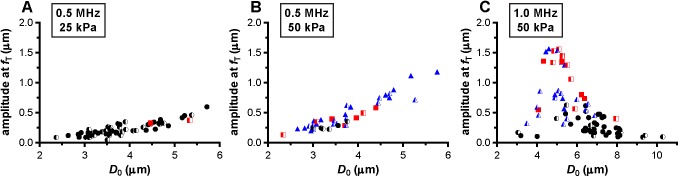
Amplitude at the fundamental frequency, fT.For microbubbles insonified at a frequency of 0.5 MHz and a P_ of 25 kPa (A), frequency of 0.5 MHz and P_ 50 kPa (B), and frequency of 1 MHz and P_ of 50 kPa (C). For figure legend, see the rightmost column of Fig 2 and Fig 3.